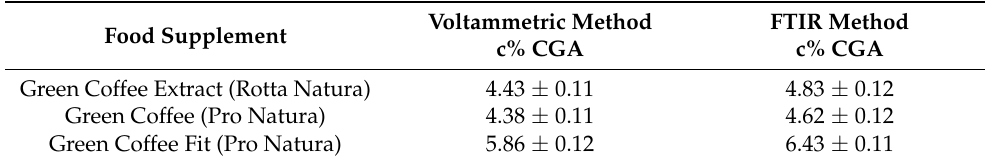
Table 7. CGA content determined in three food supplements by using voltammetric and spectrophotometric method. Food Supplement